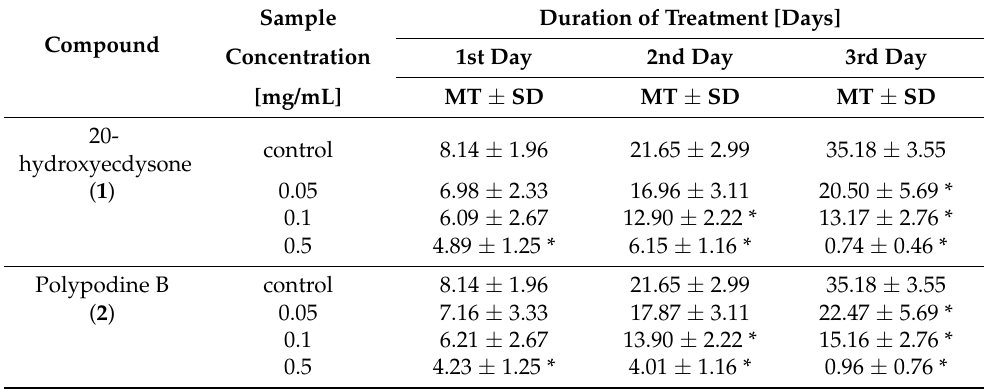
Table 7. The effect of 20-hydroxyecdysone and polypodine B isolated from Lychnis flos-cuculi on Acanthamoeba trophozoite inhibition during three-day